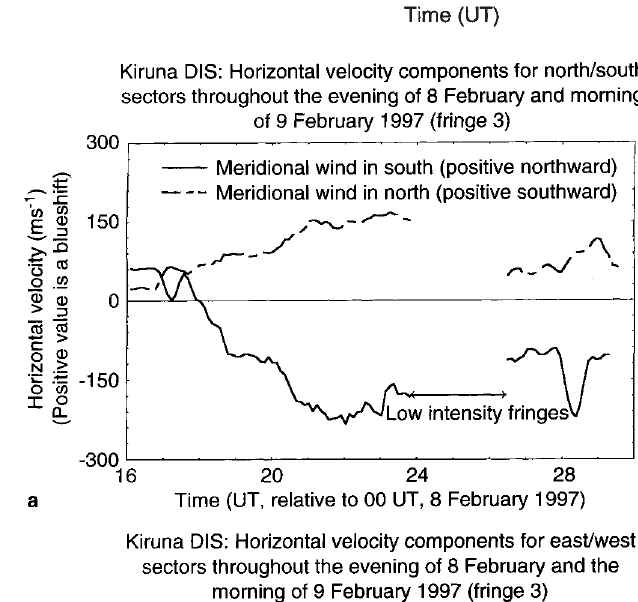
Fig. 7 Thermospheric wind be- haviour above Kiruna during the night of February 8/9